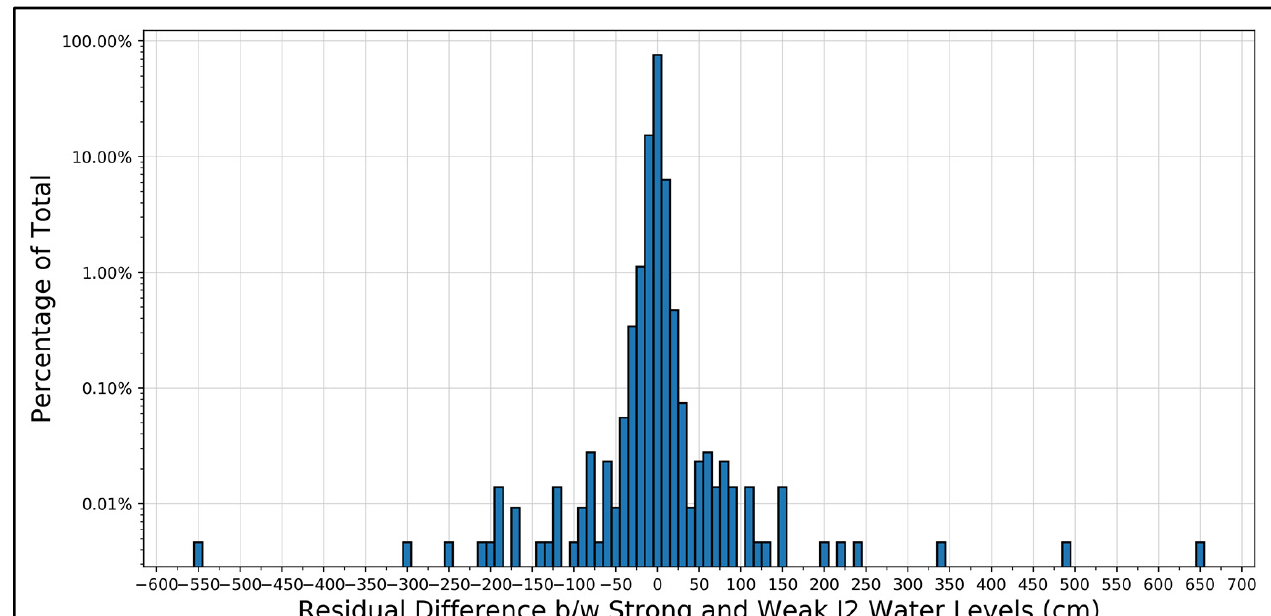
Figure 7. Frequency histogram of the residual differences from the “strong” beam and “weak” beam IS-2 derived water levels. Each bin is 10 cm wide and is centered on the 0 cm water level difference. Note the y -axis unit is the percentage of “strong” beam and “weak” beam comparisons with residual water level differences within each particular bin’s range. The y -axis is on a base 10 logarithmic scale in order to show the lower frequency bins at the tails.